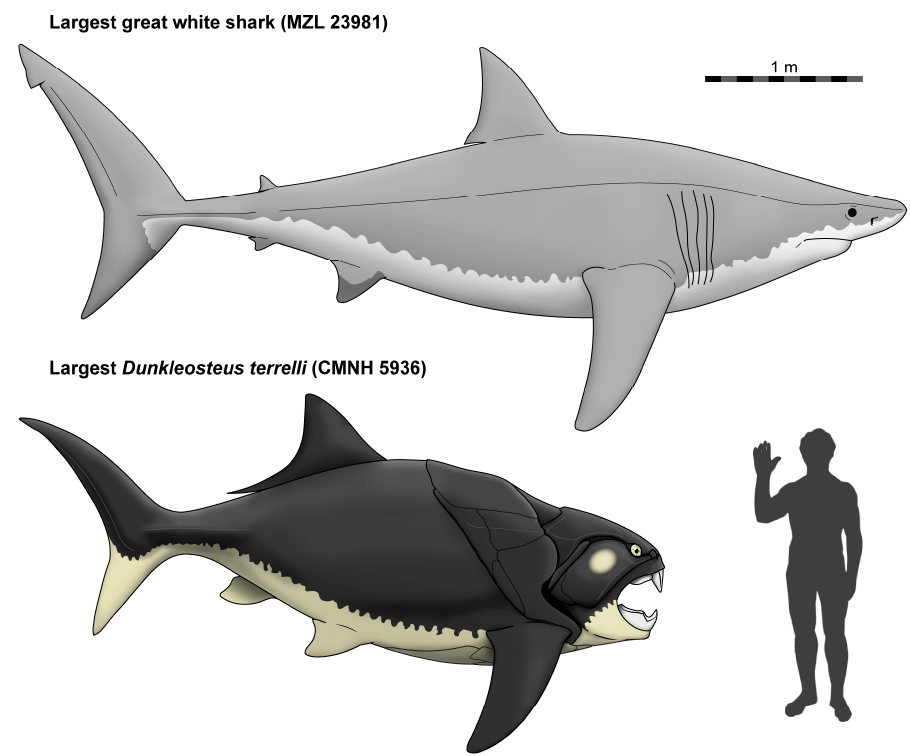
Figure 13. Reconstruction of the largest known specimen of Dunkleosteus terrelli (CMNH 5936, proportions primarily from the slightly smaller but more complete CMNH 5768), compared to one of the largest reliably measured specimens of Carcharodon carcharias (MZL 23981; [166]). A 175 cm tall human for scale (from NASA). Drawings by Russell